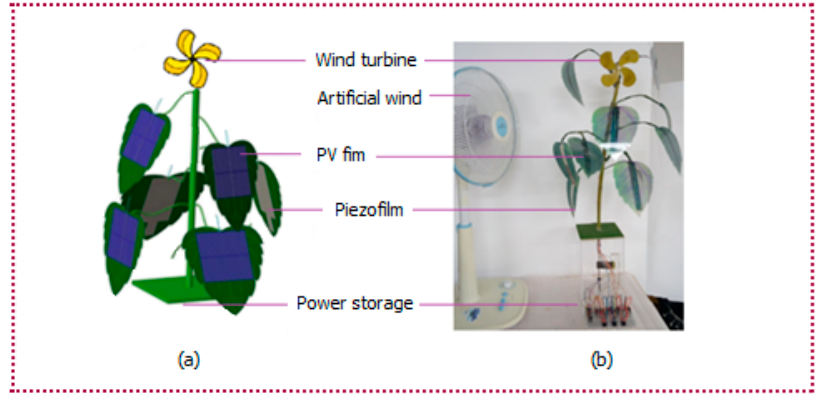
Figure 3. Tree shaped hybrid nanogenerator (TSHG) ( a ) conceptual design ( b ) actually fabrication.